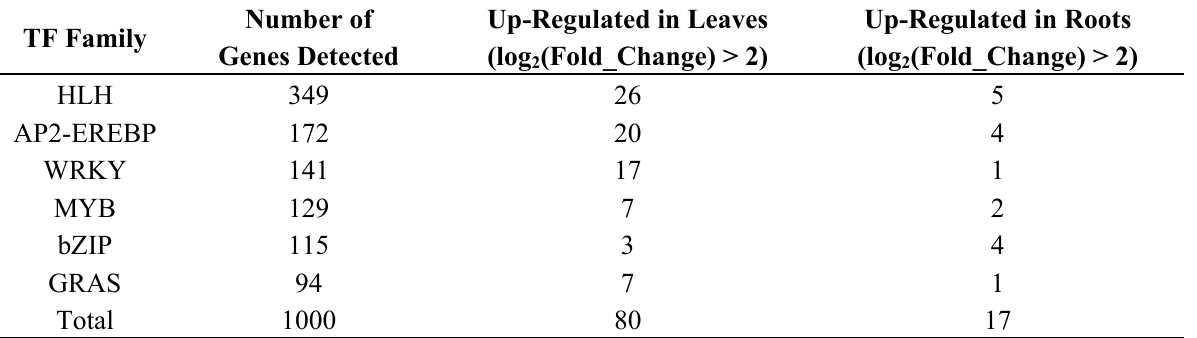
Table 6. Summary of transcription factor unigenes of G. rigescens